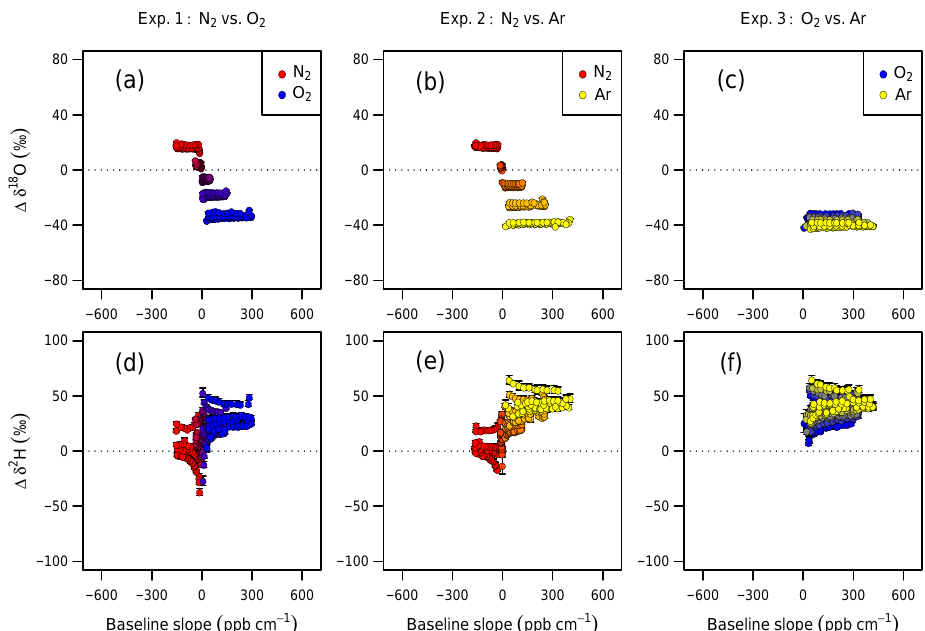
Figure 5. Relationship between the baseline slope, (cid:49)δ 18 O, and (cid:49)δ 2 H values. For each panel, n = 330 measurements of four liquid standards across a range of injection volumes (i.e., 400–2400nL, in 11 steps of 200nL each). Points represent mean values ± SD for replicates of each standard at each injection volume.